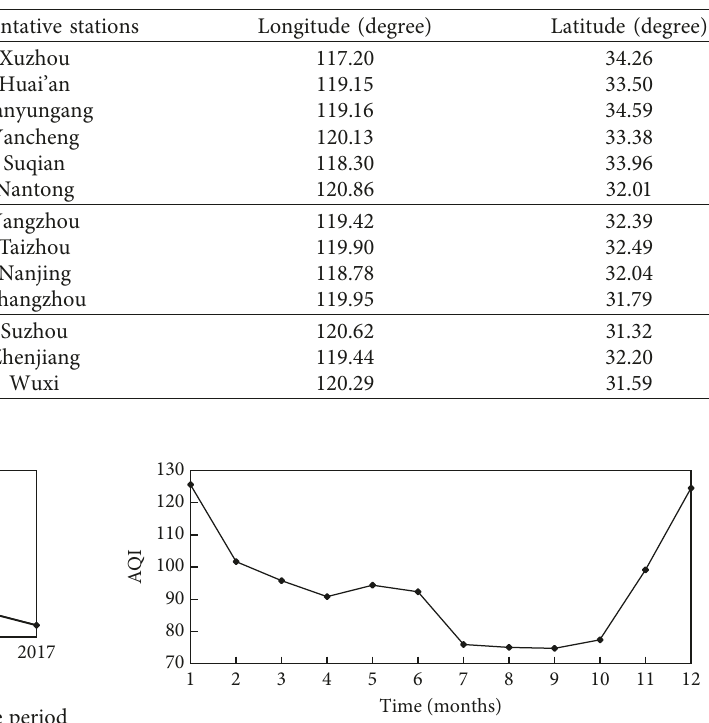
Figure 4: Monthly AQI variation in Jiangsu Province in the period 2013–2017.